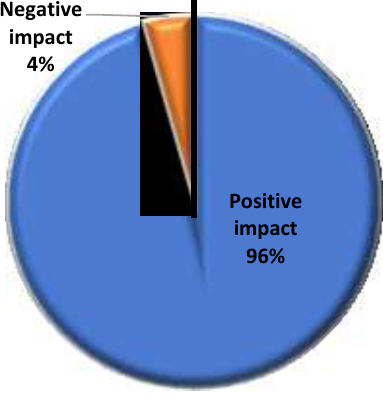
Figure 6. Existence of Tourism Impact (Source: Research Data,